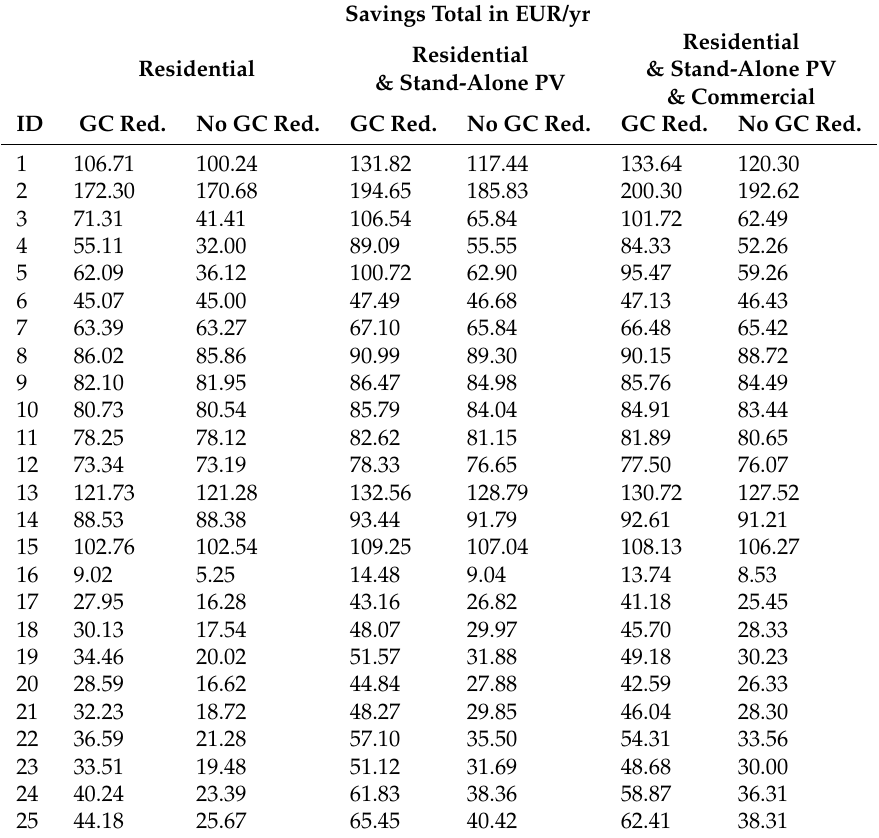
Table 13. Comparison of savings for customers 1–25, with and without reduction of grid charges.